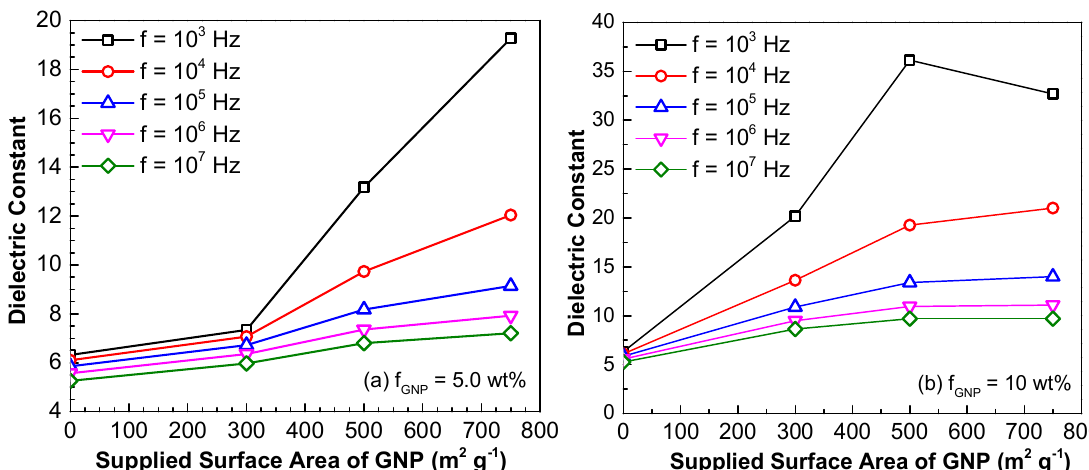
Figure 7. Dielectric constant of GNP/epoxy nanocomposites with different GNP weight fractions at ( a ) 5.0 wt % and ( b ) 10 wt % for varying supplied GNP surface area. (Note: the surface area of the GNP is the value from the grouping of the GNP (i.e., C-series) specified by the supplier).